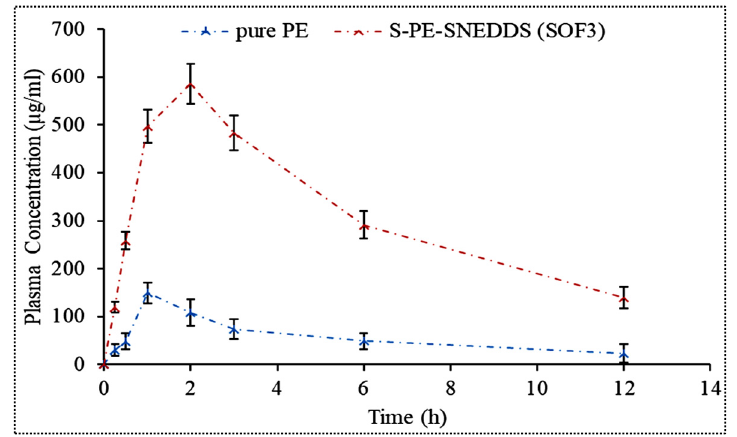
Figure 11. Plasma concentration time profile of S-PE-SNEDDS-opt and pure PE. Values are given as mean ± SD ( n = 6). Table 7. Pharmacokinetic parameters of pure PE-dispersion and S-PE-SNEDDS after single-dose oral administration. Values are given as mean ± SD ( n = 6).